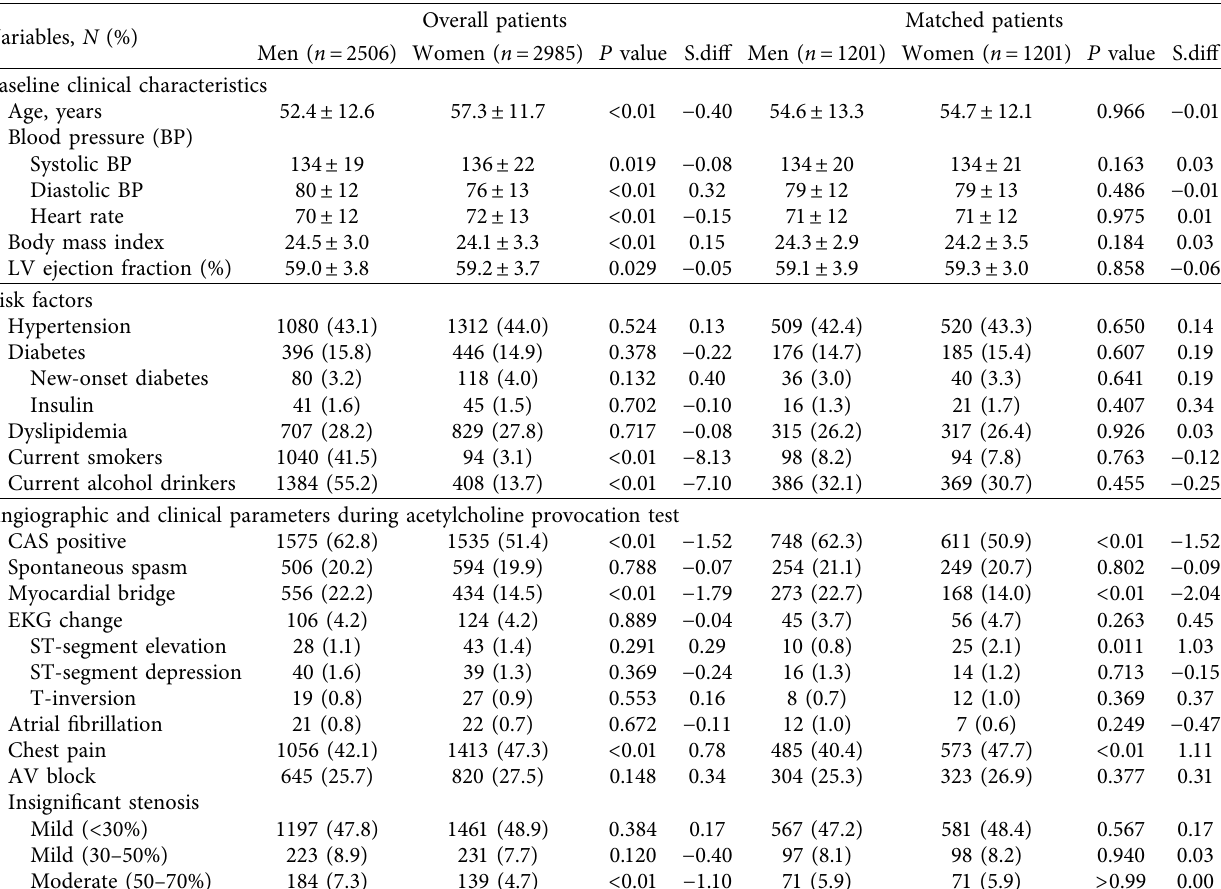
Table 1: Baseline clinical and angiographic parameters in patients who underwent acetylcholine provocation test. Variables, N